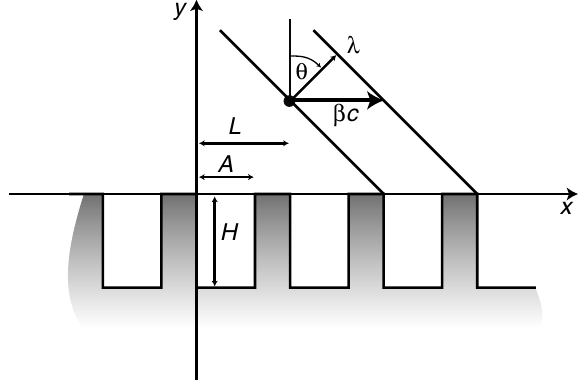
FIG. 1. Formation of Smith-Purcell radiation by an electron moving parallel to the surface of a grating with rectangular